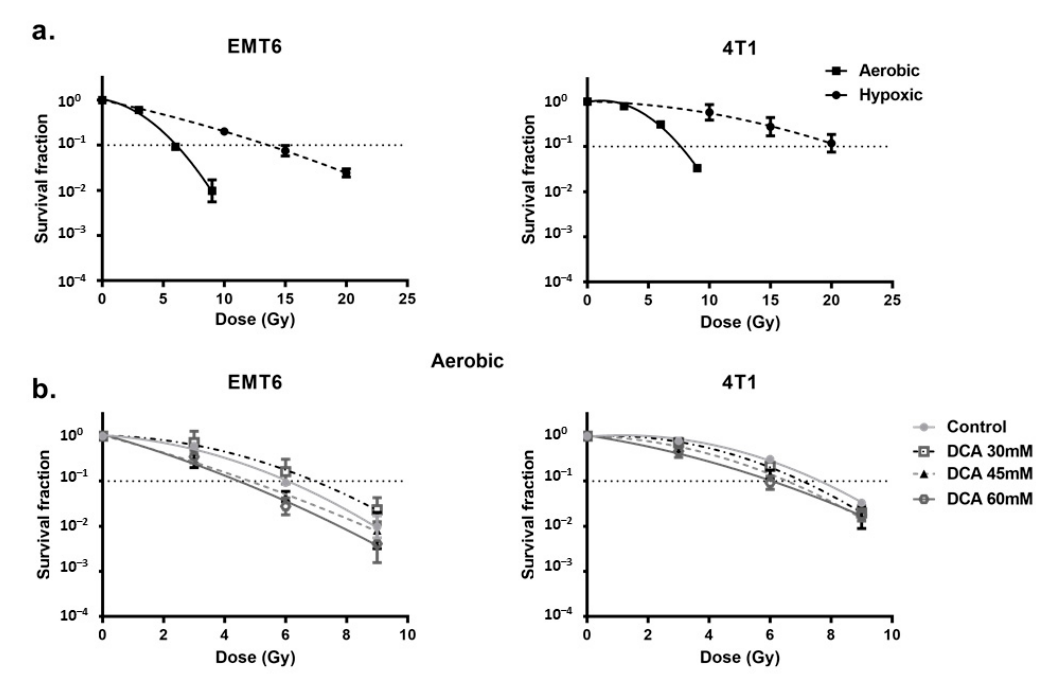
Figure 4. DCA has small radiosensitizing effects on aerobic tumor cells. EMT6 and 4T1 cells were treated with DCA overnight at indicated concentrations. ( a ) Radiosensitivity of EMT6 and 4T1 cells under either aerobic or hypoxic conditions. ( b ) Radiosensitizing effect of DCA under aerobic conditions.